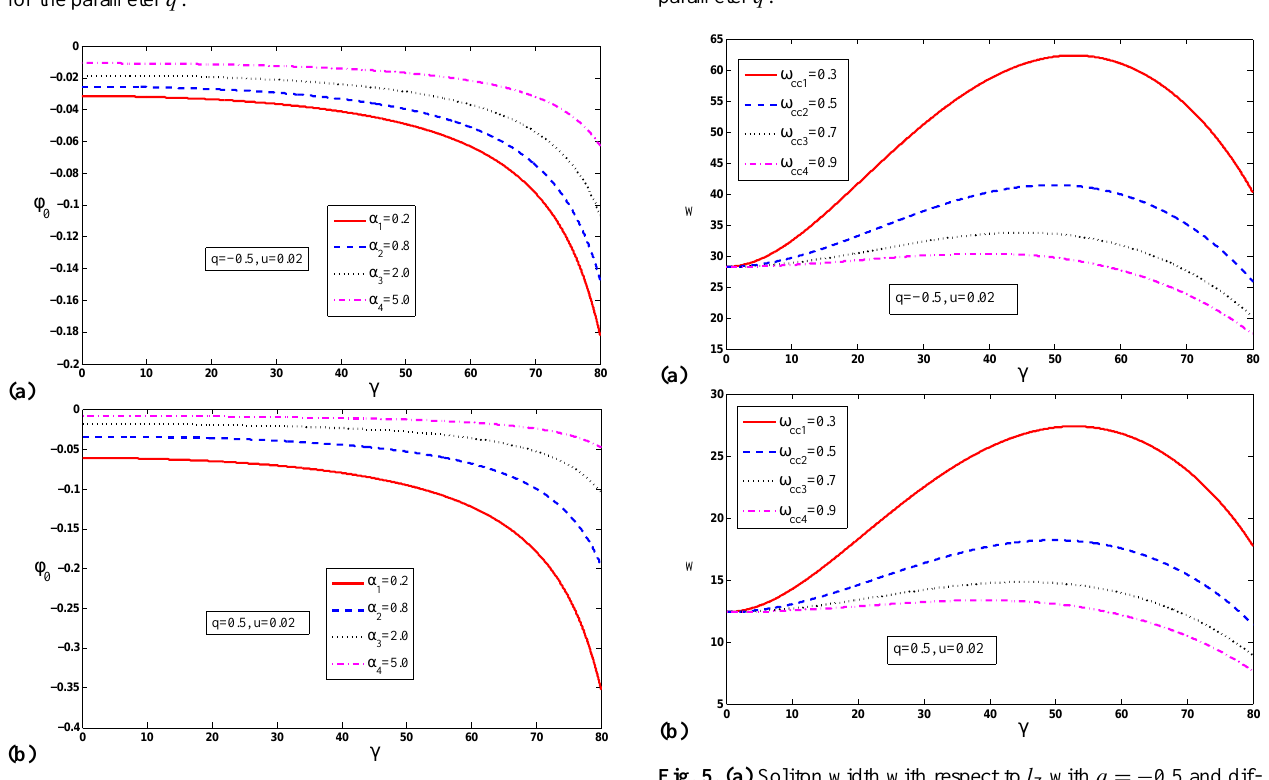
Fig. 3. (a) Maximum amplitude ϕ 0 with respect to γ with different values for the parameter α . (b) Maximum amplitude ϕ 0 with respect to γ with different values for the parameter α .